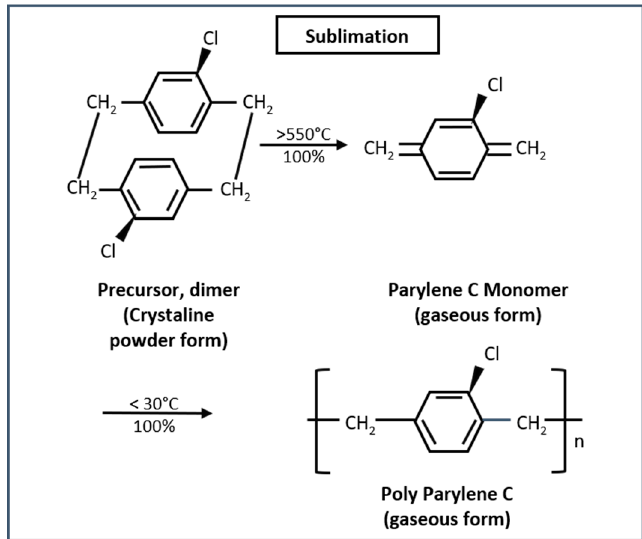
Figure 5. Parylene C sublimation process.